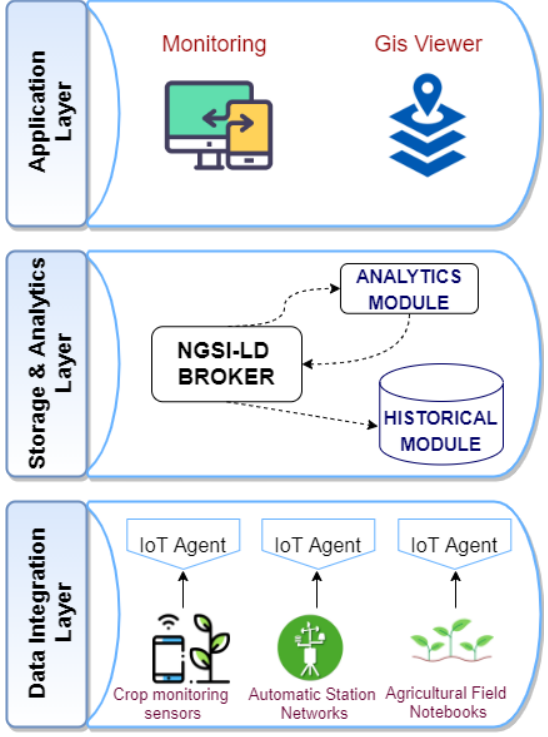
Figure 2. Diagram of the